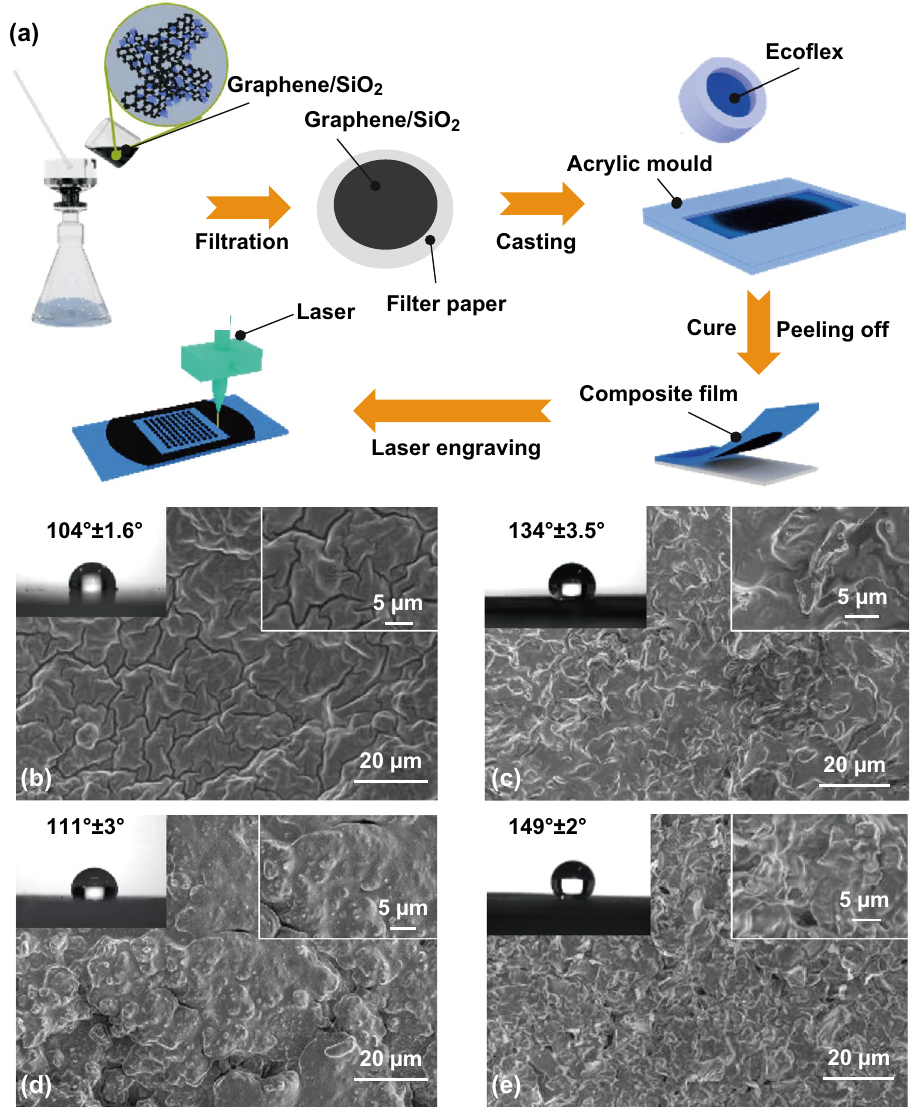
Fig. 1 a Schematic diagram of the preparation of the composite with arrays. SEM images of b Ecoflex film, c graphene/Ecoflex composite film, d SiO 2 /Ecoflex composite film, and e graphene/SiO 2 /Ecoflex composite film. The insets in b – e are the corresponding water contact